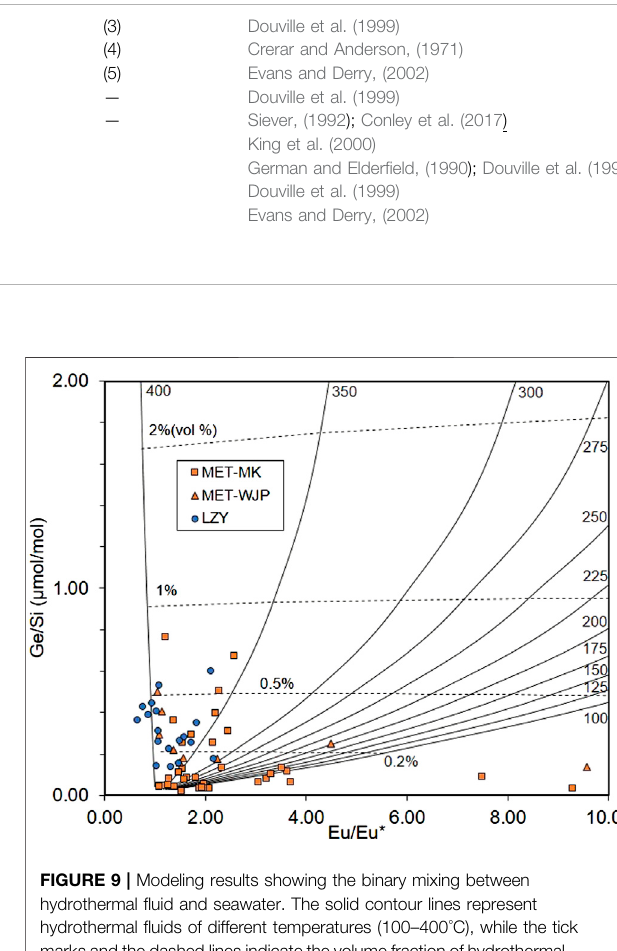
TABLE 1 | Parameters of the binary-mixing model. Parameter